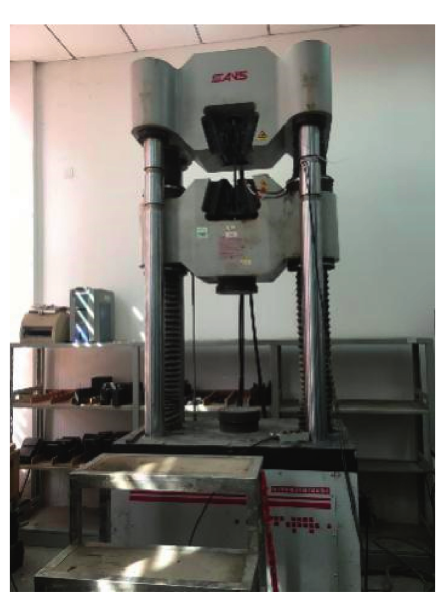
Figure 5: Loading instrument for the material